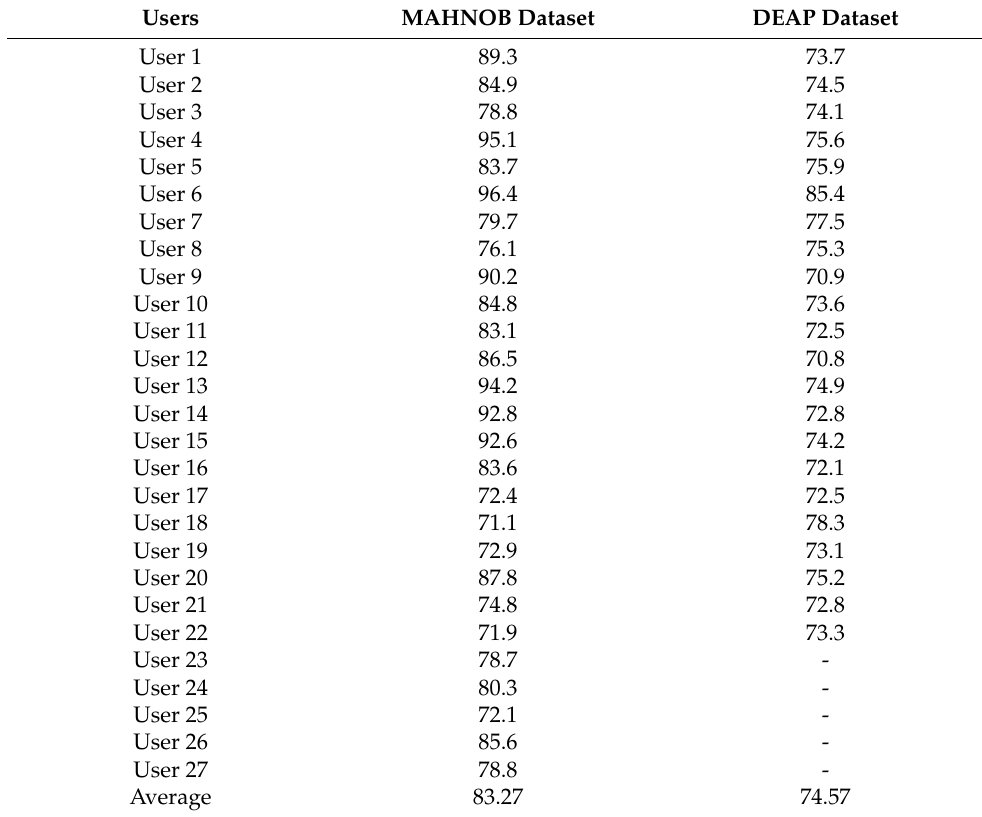
Table 3. EEG-based results in terms of accuracy (%).